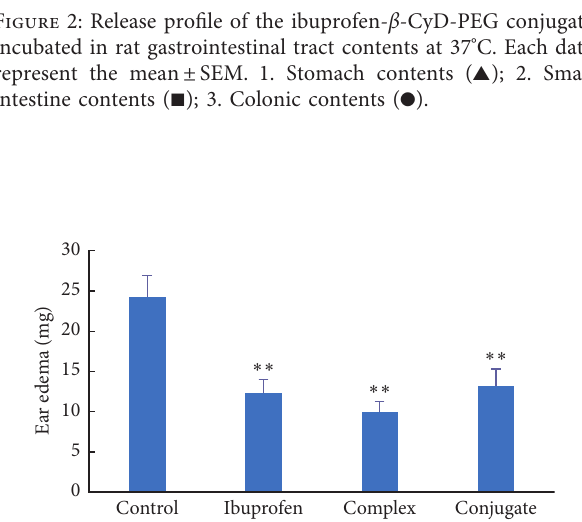
Figure 3: Effect of ibuprofen, complex, and conjugate on xylene- induced ear swelling in mice model ( n � 8). Each column represents the mean ± SEM. The asterisks denote the significance levels in comparison with the control group, ∗∗ P ＜ 0.01.